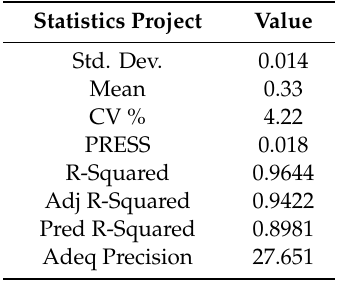
Table 5. Statistical analysis of regression equation